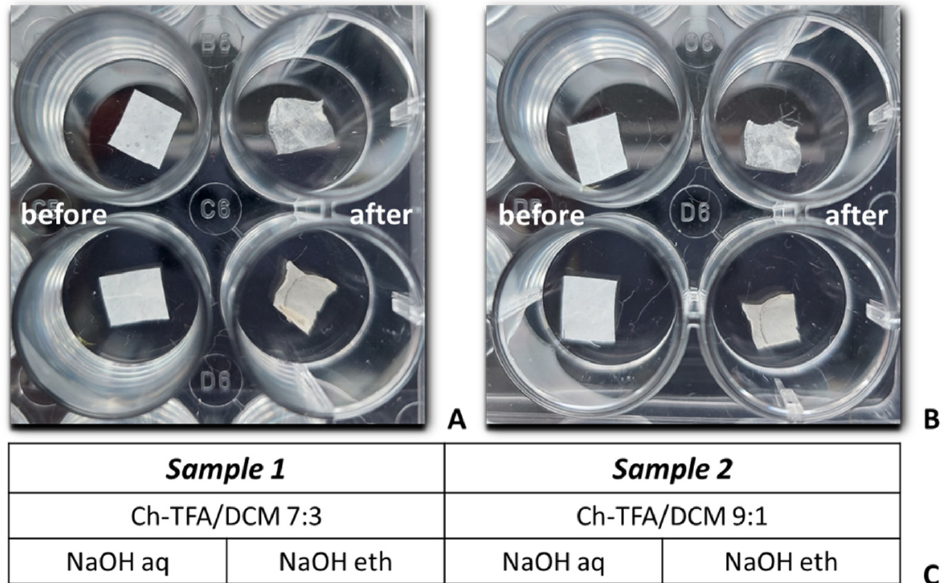
Figure 10. Macroscopic image of chitosan membranes—sample 1 ( A ) and sample 2; ( B ) before and after 24 h alkali treatment with 1 M NaOH aqueous (upper row) and 1 M NaOH ethanol solutions (lower row). Types of samples prepared for research ( C ).